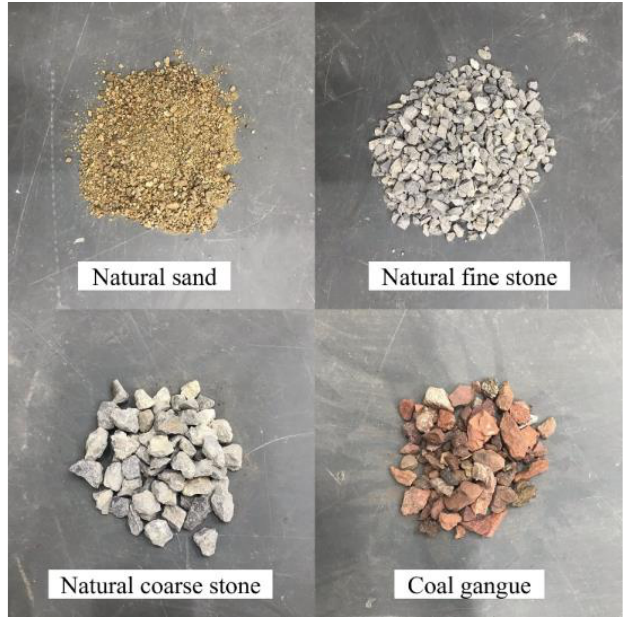
Figure 3. Concrete aggregate.